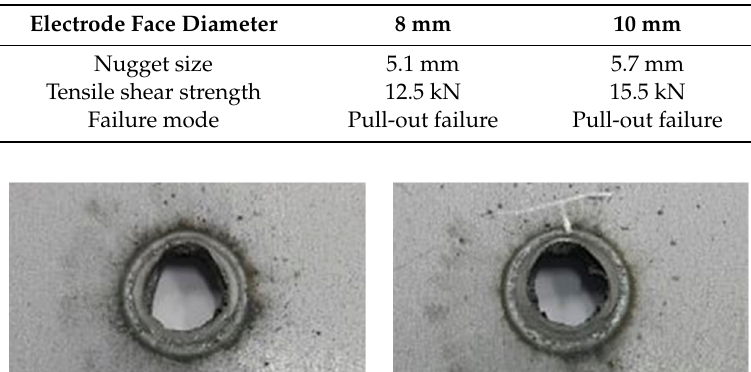
Table 4. E ff ect of welding conditions on specimen properties: Nugget size, tensile shear strength, and failure mode.